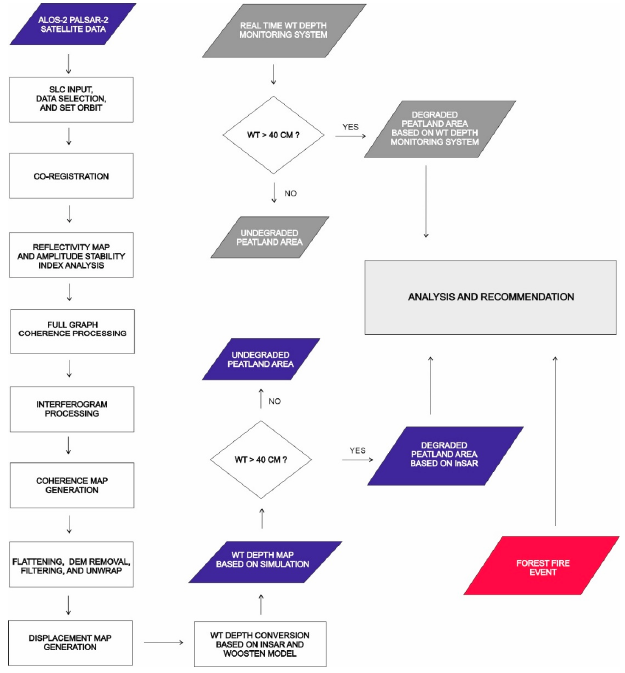
Figure 2. Flowchart of research